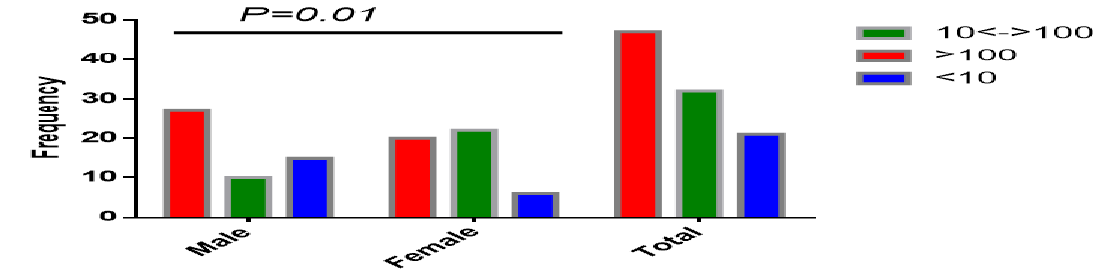
Figure 2. Frequency of antibiotic titration of anti-hepatitis B in samples analyzed by